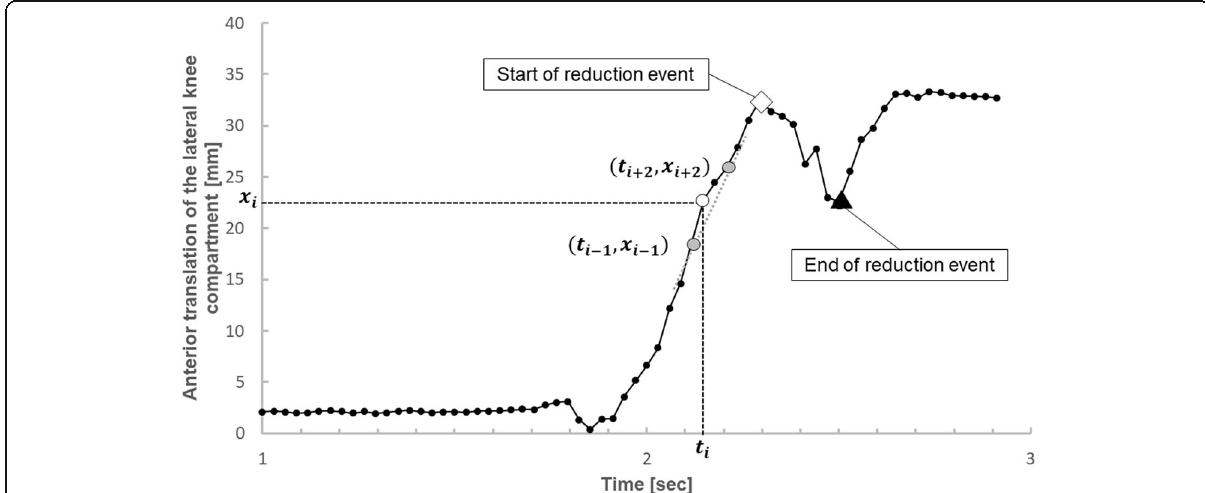
Fig. 3 Illustration of the running slope of four values (dashed grey line) for the measured value ( t i , x i ) (white mark), calculated based on the values ( t i − 1 , x i − 1 ) and ( t i +2 , x i +2 ) (grey marks). Furthermore, the start of the reduction event is labelled with a white rhombus, the end of the reduction event is labelled with a black triangle. The difference in anterior translation of the lateral knee compartment between the start and the end of the reduction event is used for the quantification of the pivot shift